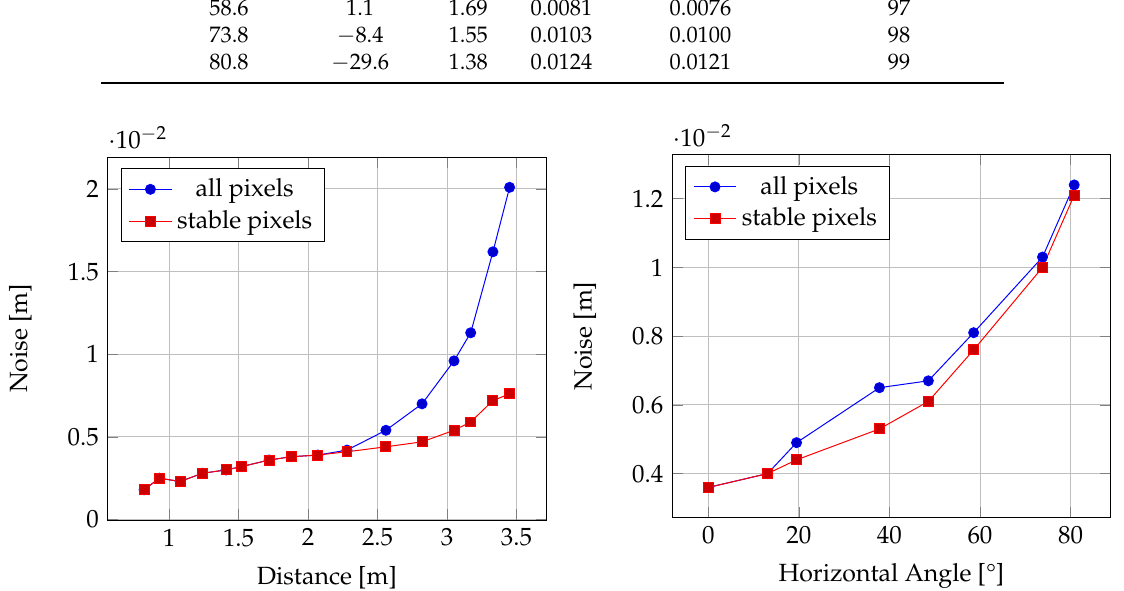
Figure 8. Noise of the distance measurements of the HoloLens ToF sensor against distance and inclination of a captured plane. Stable pixels are pixels that have range measurements in at least 75% of